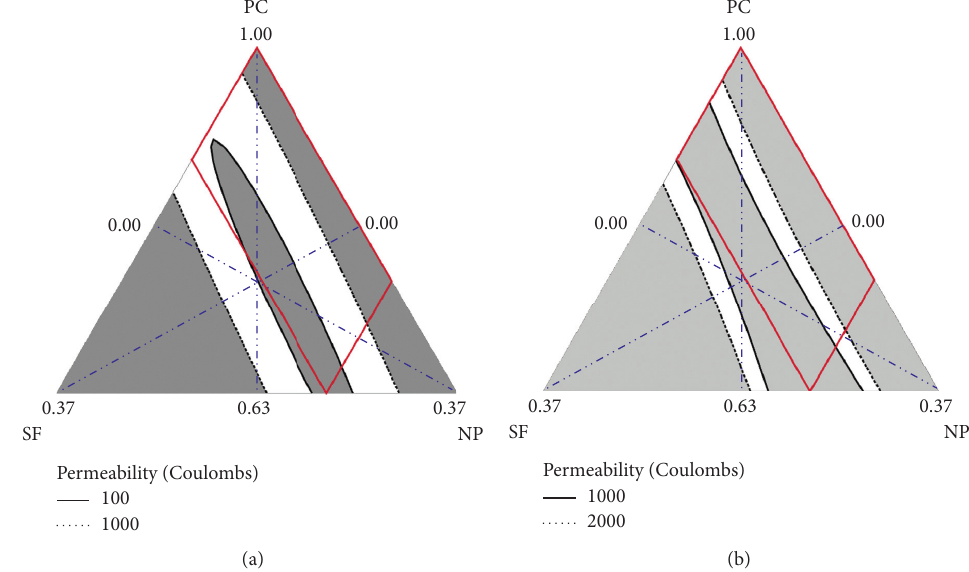
Figure 13: Permeability optimization of concrete that incorporates a blend of binders. (a) ( w / b ) � 0.25. (b) ( w / b ) �